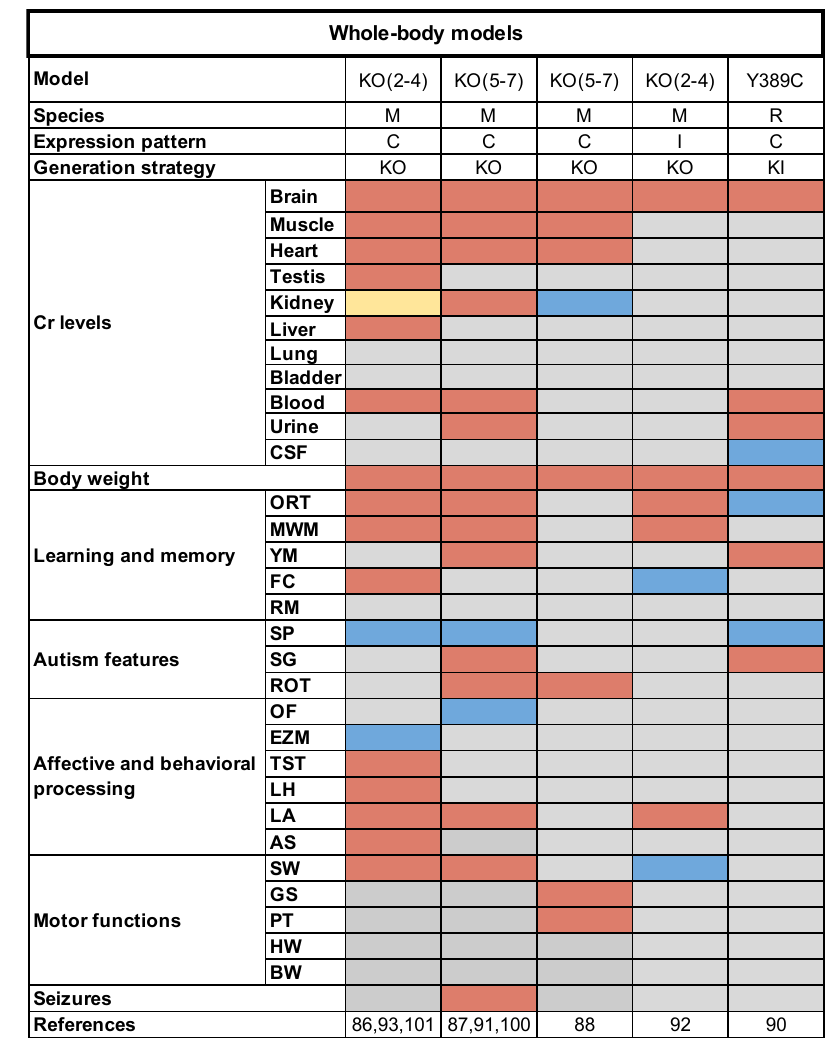
Figure 1. Heatmap representation of the cluster of whole-body animal models for CTD carrying different deletions/mutations of the SLC6A8 gene. Species (M: mouse; R: rat) expression patterns of a mutated allele (C: constitutive; I: inducible) and model generation strategy (KO: knock-out; KI: knock-in) were also cited. The phenotypic traits for each model are indicated (ORT: object-recognition task; MWM: Morris water maze; YM: Y maze; FC: fear conditioning; RM: radial maze; SP: social preference; SG: self-grooming; ROT: rotarod; OF: open field; EZM: elevated zero maze; TST: tail suspension test; LH: learned helplessness; LA: locomotor activity; AS: acoustic startle; SW: swimming behavior; GS: grip strength; PT: pole test; HW: hang wiring; BW: beam walk). Red squares mean significantly higher or lower performance with respect to WT animals. Blue squares refer to phenotypes with no differences between genotypes. Yellow square indicated mixed evidence. Grey squares are for not investigated tasks.